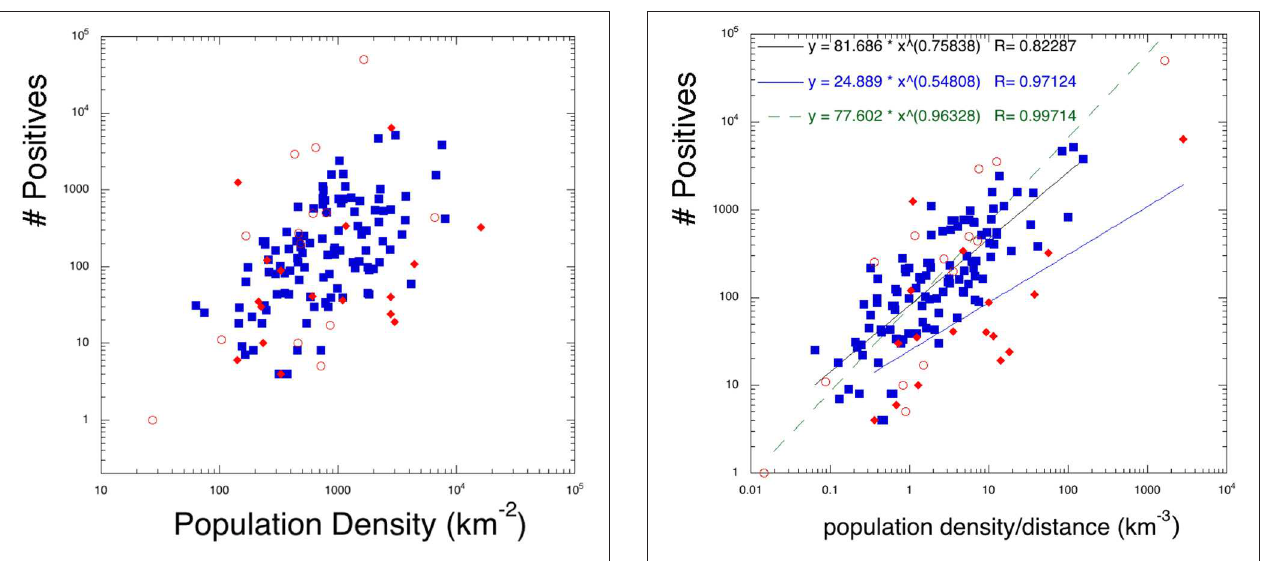
FIGURE 7 | Number of positives as function of the density of the population divided by the distance from the “center of infection” for the different countries as in the previous Figures 5 , 6 (on March 20, 2020). A power law dependence is also included, suggesting a lower spread for the South Korean case. Symbols as in Figures 5 , 6